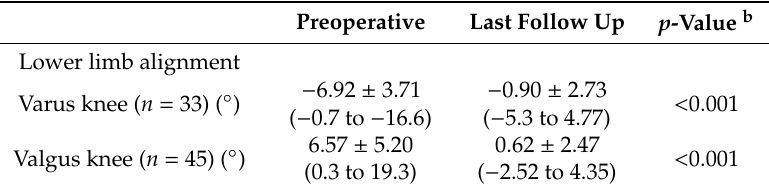
Table 6. Radiologic results for lower limb alignment a